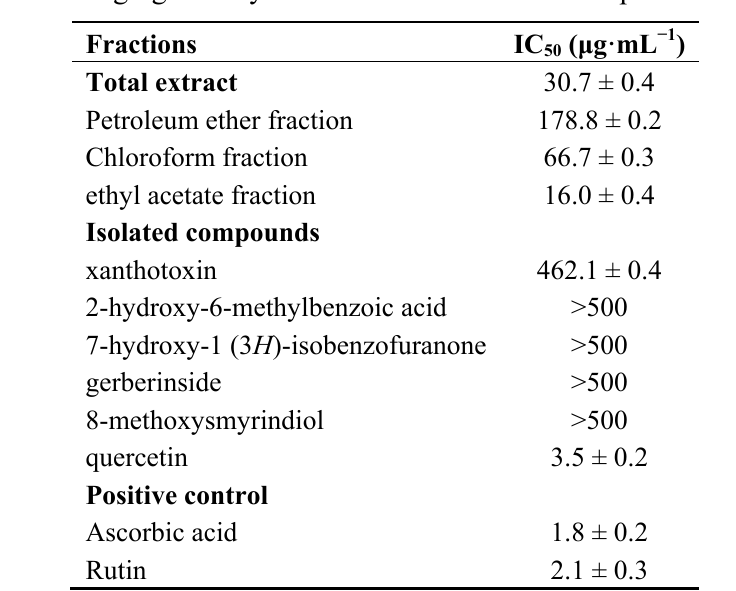
Table 1. DPPH scavenging activity of fractions and isolated compounds from G. anandria